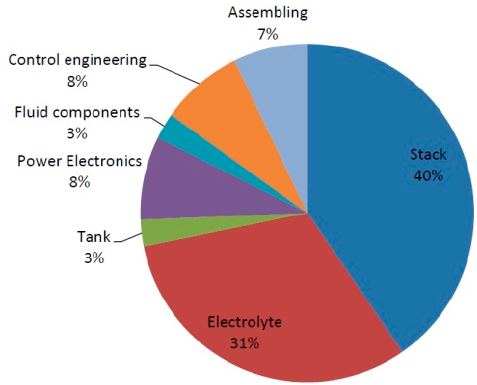
Figure 3. Breakdown of system costs of a 10 kW/120 kWh vanadium redox flow battery system.